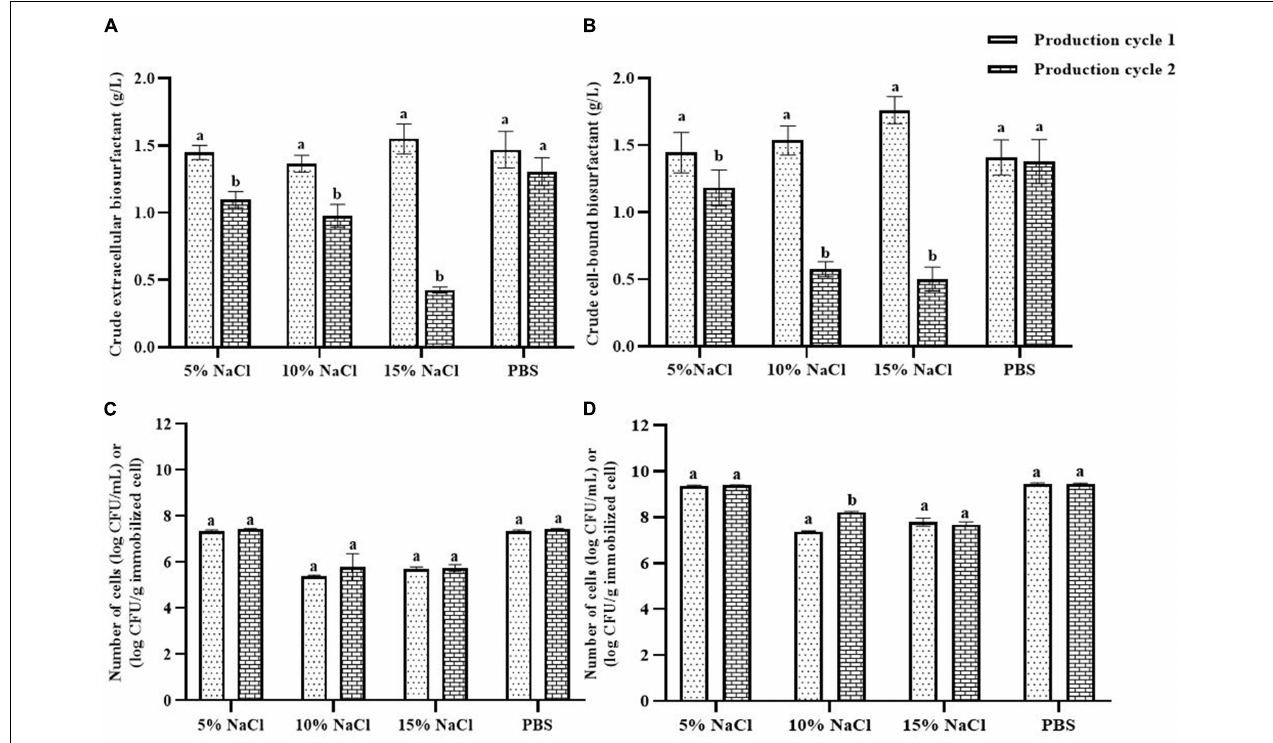
FIGURE 3 | Comparison of extracellular biosurfactant yield (A) and cell-bound biosurfactant yield (B) observed with different washing solutions after the 1st production cycle. The immobilized cells were washed with either sodium chloride (NaCl) solution at 5, 10, and 15% or phosphate buffer saline (PBS) solution, pH 8.0 before reused in the 2nd production cycle. The numbers of suspended (C) and immobilized cells (D) were monitored after each production cycle. The biosurfactant yield was based on volume of production medium. The yields of extracellular/cell-bound biosurfactants were compared between production cycles. Error bars represent mean ± standard deviation ( n = 3). Two-way ANOVA: Sidak’s Multiple Comparison Test was used for statically analysis. Different letters represent the significant value ( P < 0.05).